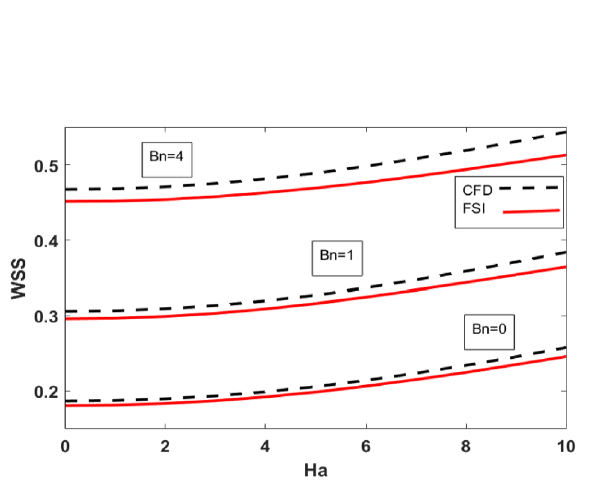
Figure 9. WSS along the upper wall vs Ha for different